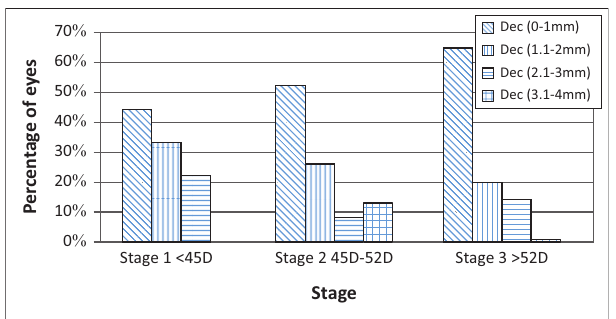
FIGURE 2: The frequency distribution of cone apical decentration and the Stage of keratoconus.